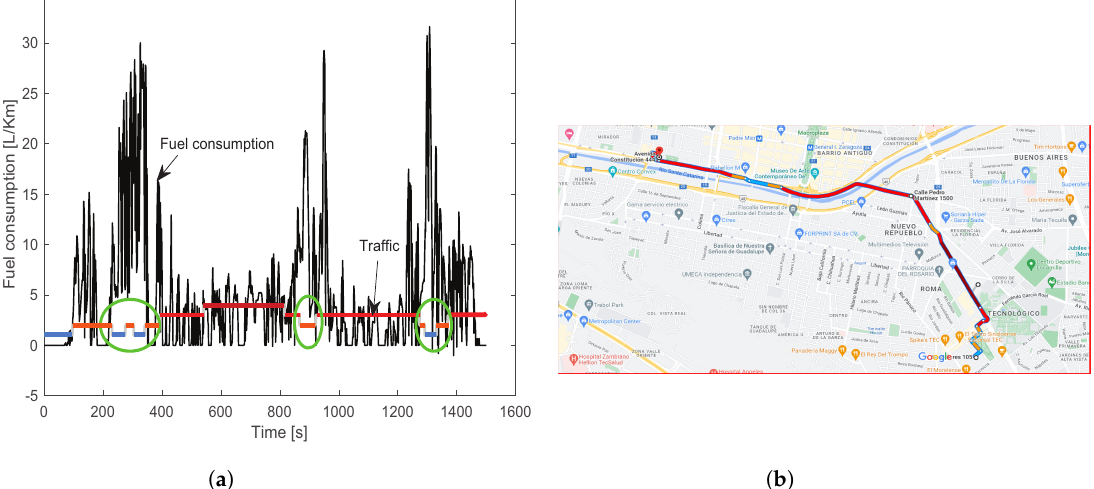
Figure 10. ( a ) Analysis of fuel consumption concerning traffic and ( b ) Google traffic map, for experiment